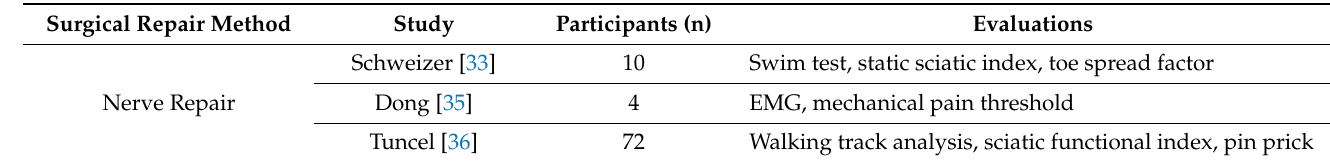
Table 1. Participant number and outcome evaluations studies of animal nerve repair surgeries with use of ADSCs. Only studies that evaluated at least one functional outcome are listed in the